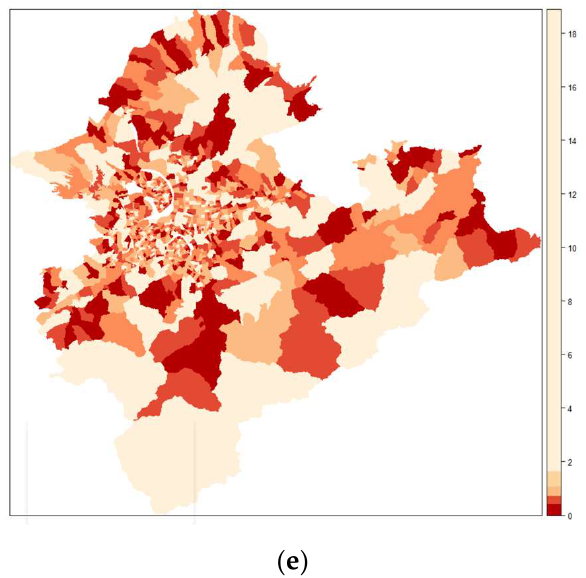
Figure 3. Comparison of four different Bayesian hierarchical models: ( a ) Poisson, ( b ) Poisson spatial, ( c ) negative binomial, and ( d ) negative binomial spatial on the relative risks, the observed number of adults served divided by the expected number of adults served, of the supply counts of adult surgical masks against the raw relative risks ( e ) by village in Taipei metropolitan areas.